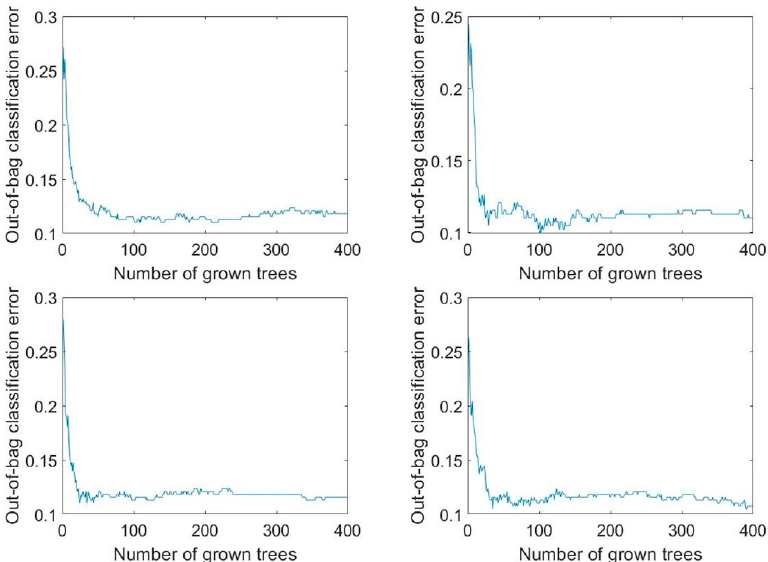
Figure 5. Number of grown trees vs. out-of-bag classification (OOBC) error results generated from four random forest model replicate runs.